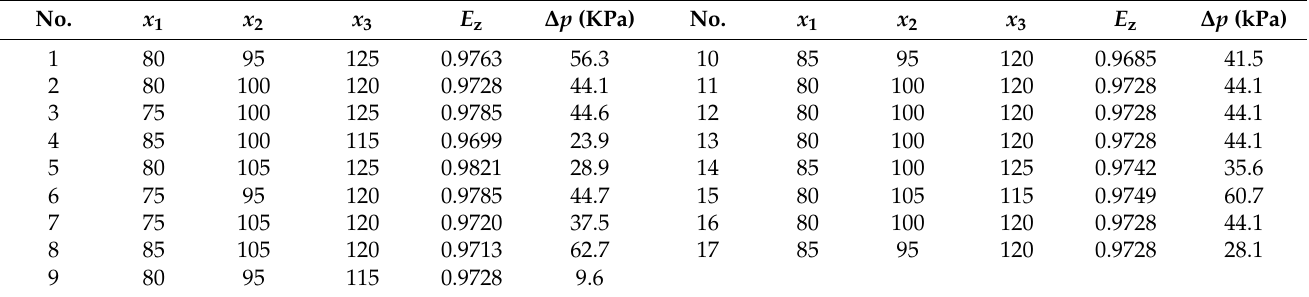
Table 2. Design and Test Results of